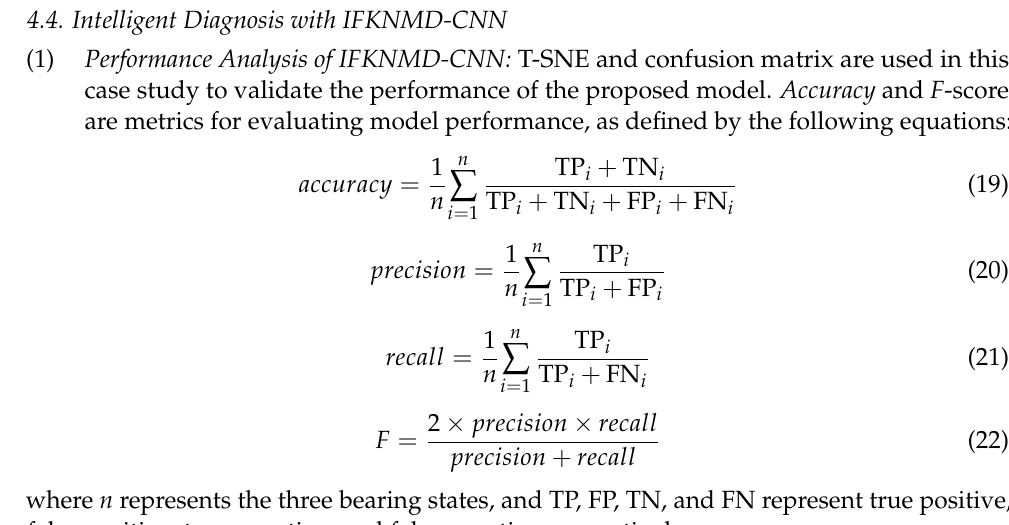
Figure 4. Structure of CNN network.